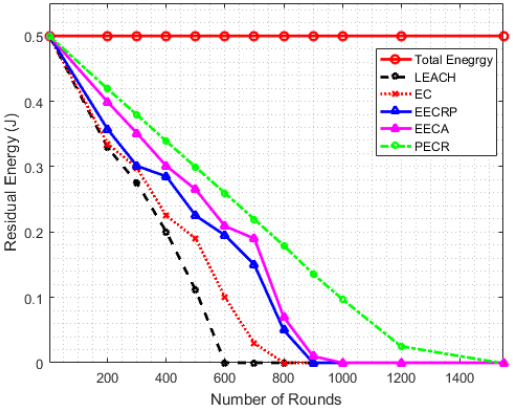
Figure 8. The residual energy of the WSN.